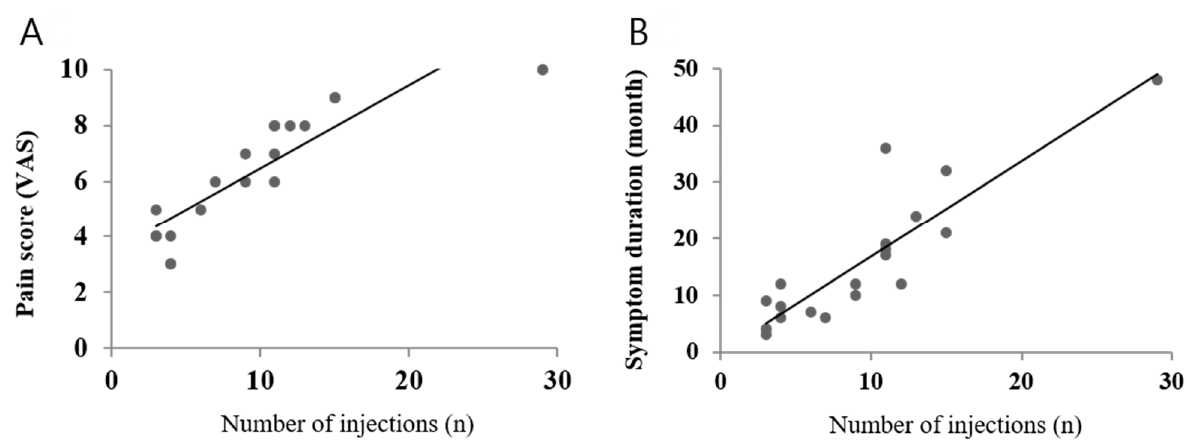
Figure 3. Relationship between pain score and the number of injections ( A ) and between symptom duration and the number of injections ( B ) analyzed via simple linear regression.